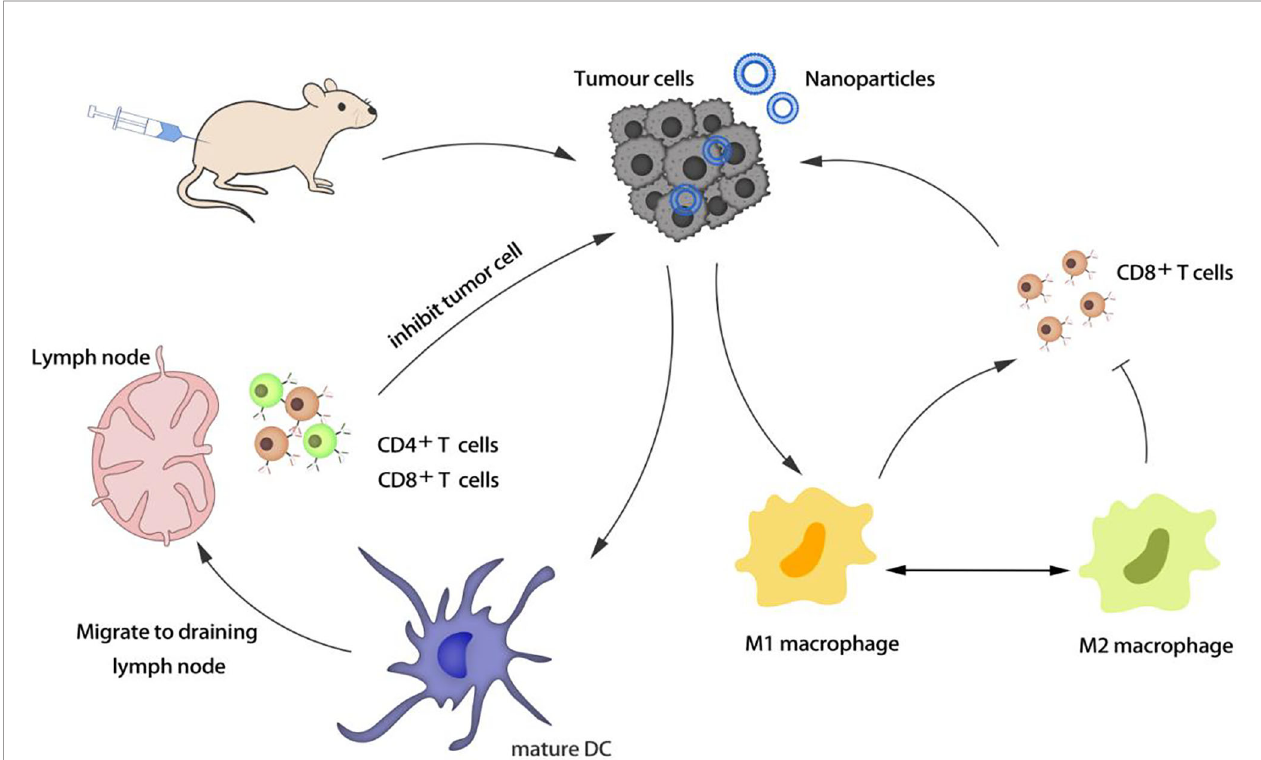
FIGURE 1 | Activation and regulation of antigen presenting cells